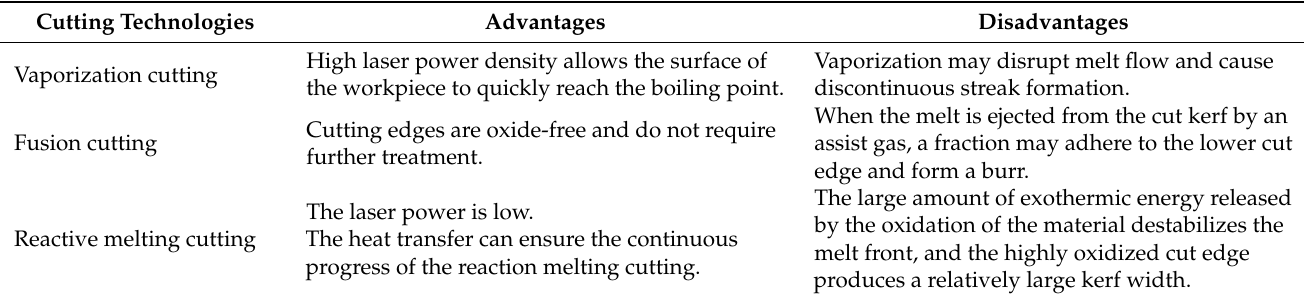
Table 1. Advantages and disadvantages of different cutting